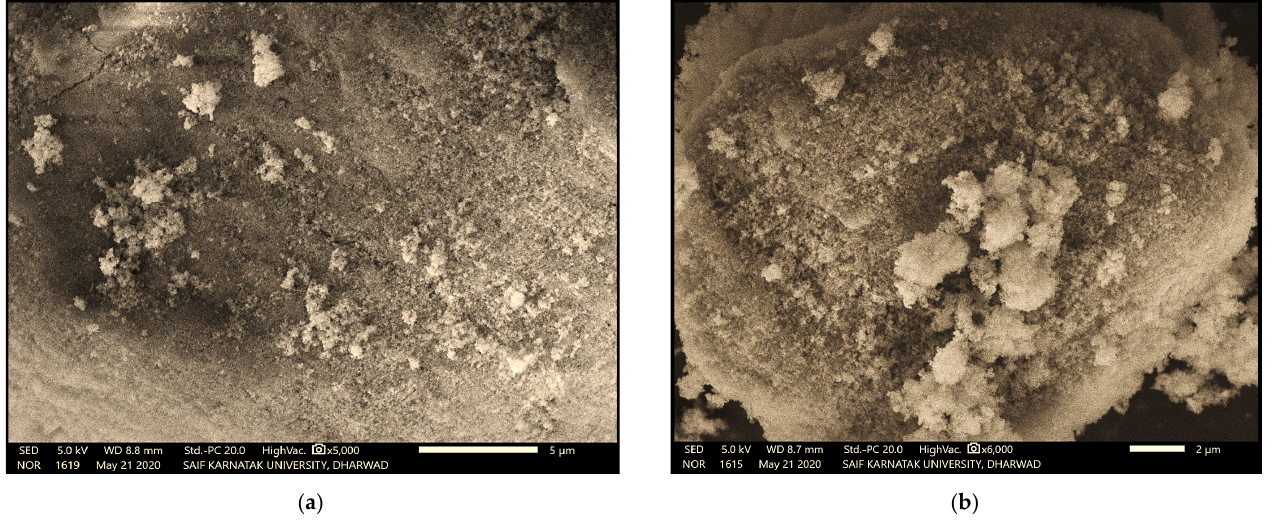
Figure 5. SEM analysis: ( a ) 5000x and ( b ) 6000x magnification.